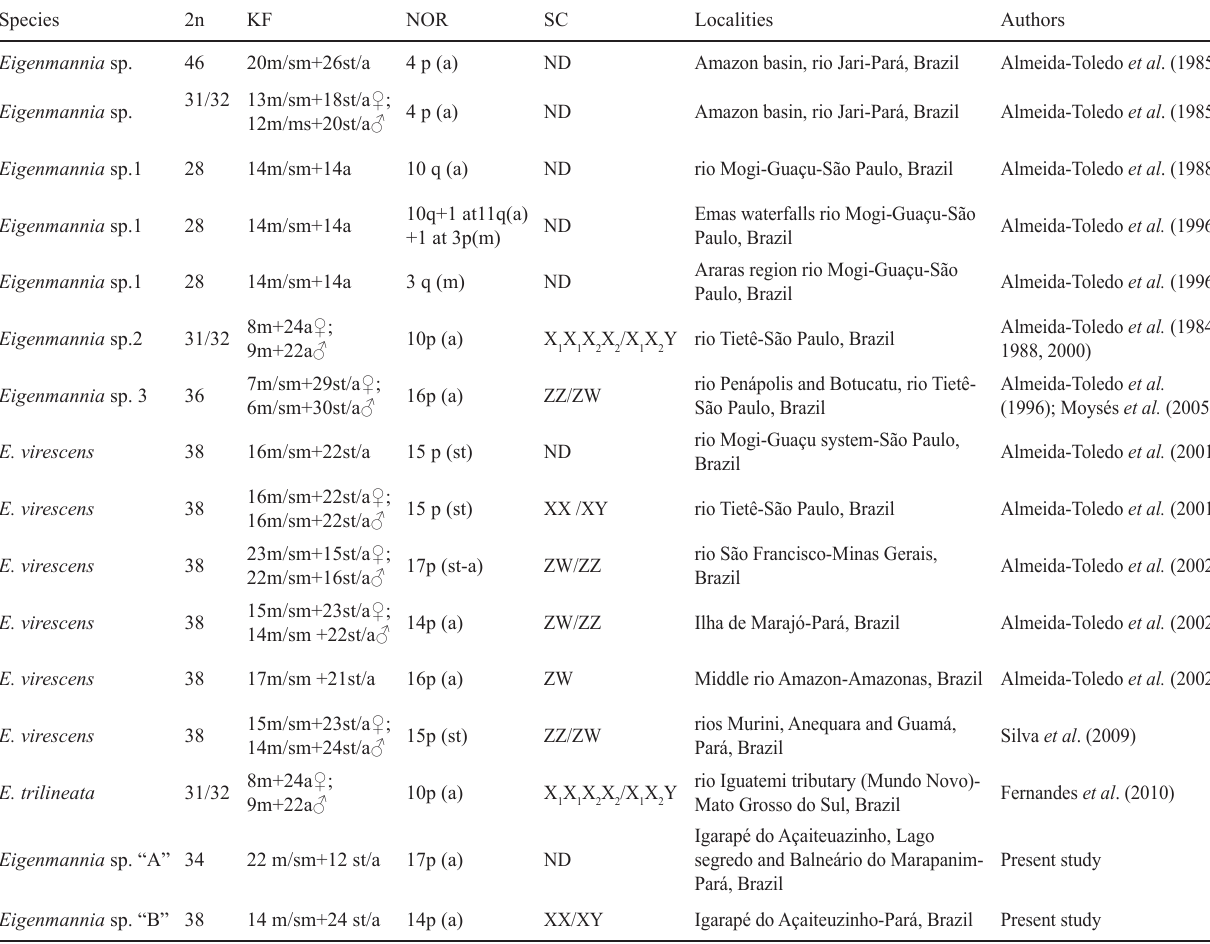
Table 1. Karyotypic studies in the genus Eigenmannia . Legend: 2n = diploid number; SC = Sex Chromosomes; ND = Not differentiated; KF = Karyotypic Formula; NOR = Nucleolar Organizing Region; CH = Constitutive Heterochromatin; CB = C band; p = short arm; q = long arm; m = metacentric; sm = submetacentric; st = subtelocentric; a = acrocentric. Symbols: (♀) = Female; (♂) = Male; (+) = technique performed on karyotype; (-) = technique not performed on karyotype. Species 2n KF